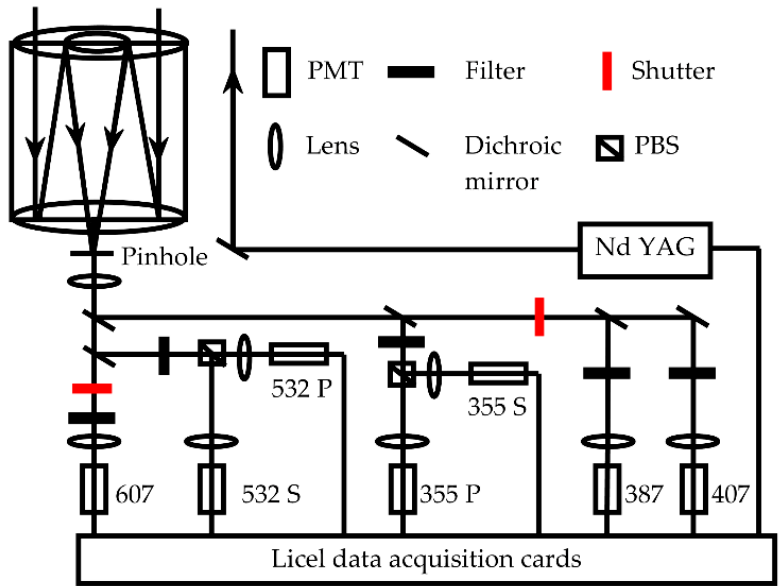
Figure 1. The schematic diagram of the Raman polarization lidar developed in this study. The LR can be retrieved using the sun photometer [42] or by integrating cloud-aerosol lidar with orthogonal polarization (CALIOP) total attenuated backscatter coefficients ( TABC ) and moderate resolution imaging spectroradiometer (MODIS) aerosol optical depths (AOD) [43]. Additionally, it can be derived by constraining the lidar solution using column AOD from co-located ground-based photometers and calculating a layer- averaged LR based on aircraft-based observations [44]. The vibrational Raman method is highly accurate, simple to manufacture, and requires no additional parameters in this experiment. The dust extinction coefficient ( α d ), the dust backscatter coefficient ( β d ), and the profile of the LR utilized in this study were computed using the method proposed by Albert Ansmann [45]. The molecules extinction coefficient ( α m ), the dust backscatter coefficient ( β m ), and the height profile of the molecules density are estimated using air pressure (P) and temperature (T) detected at various heights by a sounding balloon [46]. The dust mass concentration M d,z can be computed using Equation (1).